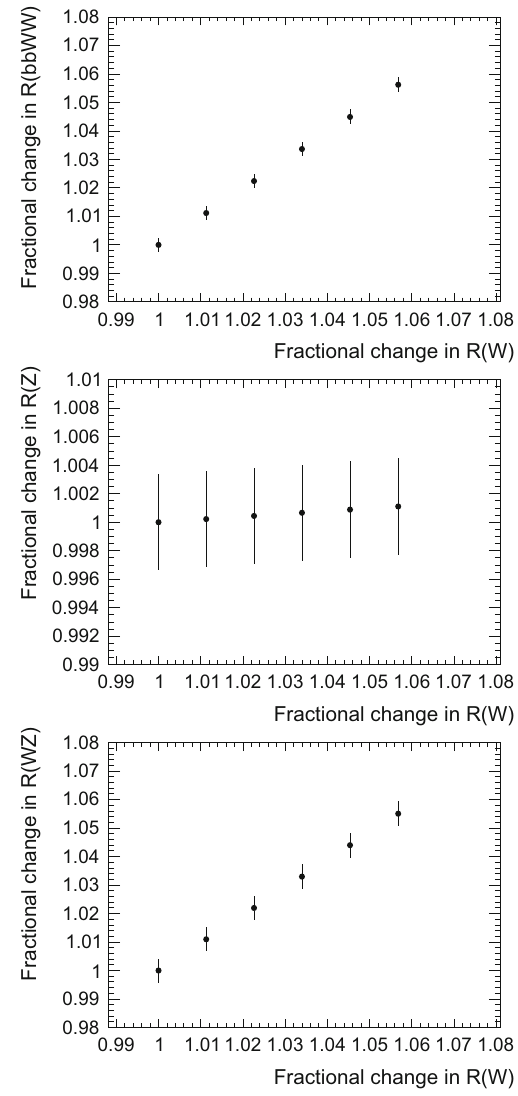
Fig. 8 The fractional change in R ( bbWW ) (upper), R ( Z ) (middle), and R ( W Z ) (lower), as a function of the fractional change in R ( W ) , obtainedbyreweightingeventsatgeneratorlevelasdescribedinthetext. The displayed error bars illustrate the expected experimental statistical uncertaintyon the relevant quantity, and are completelycorrelatedpoint topoint.MCstatisticaluncertaintiesonthepoint-to-pointvariationwith R ( W ) are